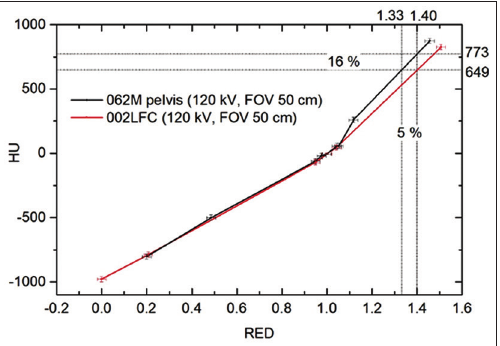
FIGURE 7. Computed tomography-relative electron density for Thorax 002LFC and computerized imaging reference systems 062M pelvis phantoms at 120 kV and field of view size 50